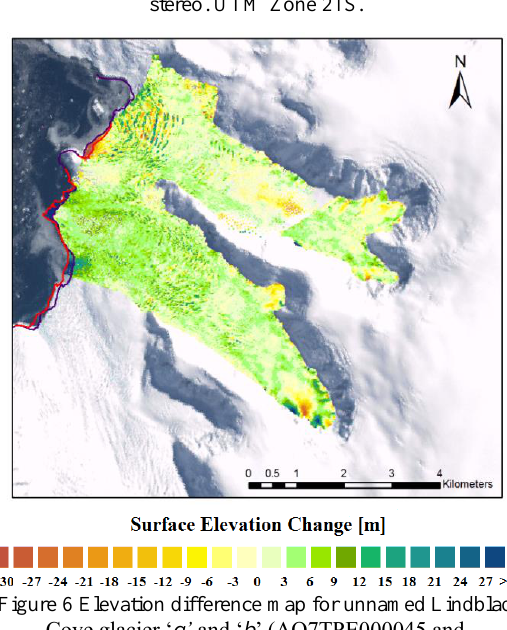
Figure 6 Elevation difference map for unnamed Lindblad Cove glacier ‘ a’ and ‘ b ’ (AQ7TPE000045 and AQ7TPE000046). Change from 1957 to 2014. The gap in the coverage in glacier ‘ a ’ is due to cloud cover. UTM Zone 21 S.